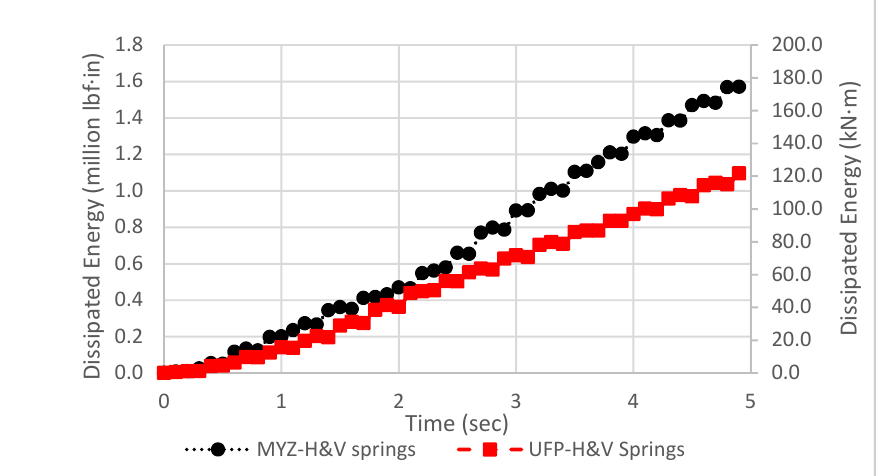
Figure 26. Cumulative dissipated energy for building models with UFP and MYZ connectors.